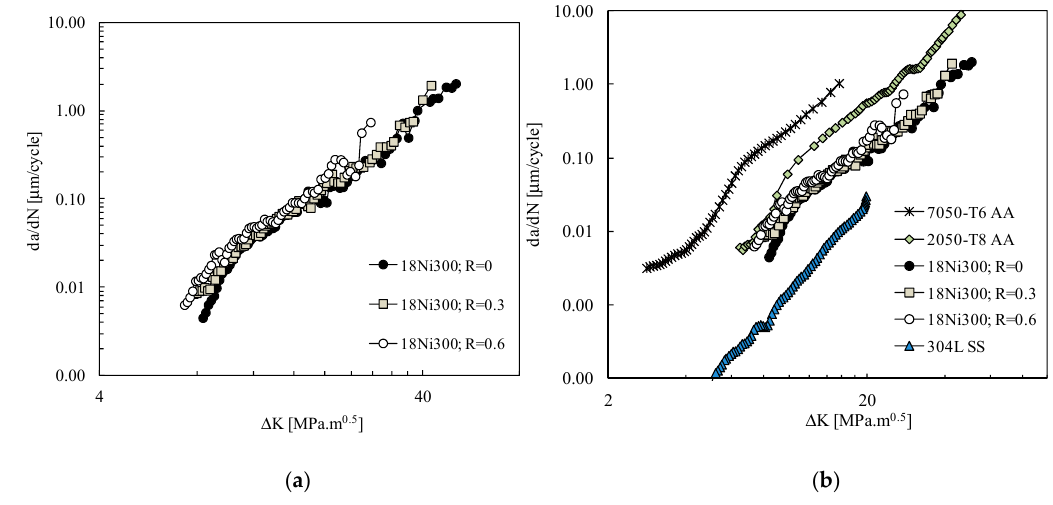
Figure 2. ( a ) da / dN- ∆ K curves (18Ni300 steel; t = 6 mm). ( b ) E ff ect of material on da / dN- ∆ K plots (R = 0.1; R = 0.05 for the Figure 2. ( a ) da/dN- Δ K curves (18Ni300 steel; t = 6 mm). ( b ) Effect of material on da/dN- Δ K plots (R = 0.1; R = 0.05 for the 18Ni300).